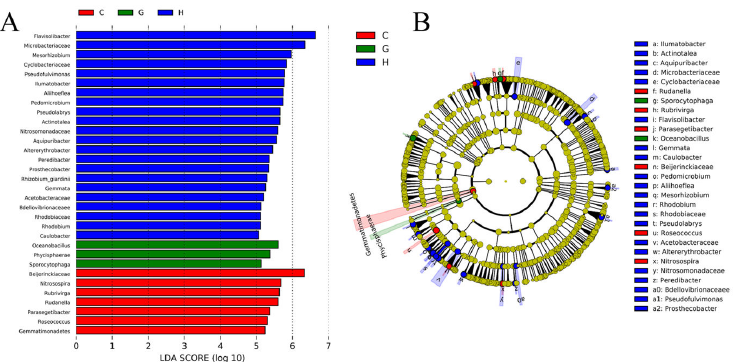
Figure 7. ( A ) Visualization of indicator genera distribution across different habitats in the 3 sites sampled from cold-desert, Qinghai Tibet Plateau, China: ( A ) Indicator bacterial groups within the three sites with linear discriminant analysis (LDA) scores higher than 3. ( B ) Cladogram indicating the phylogenetic distribution of bacterial lineages. The colored nodes from the inner to the outer circles represent taxa from the phylum to genus level. The significantly diverse taxa are signified by different colors representing the three sites. C (CNH—CuoNaHu), H (HLH—HongLiangHe), G